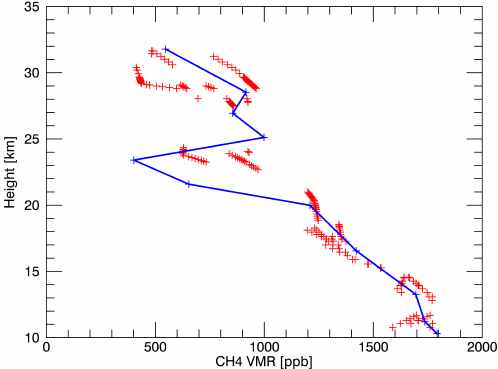
Figure 2. Comparison of the vertical profile obtained during flight B45 with the closest satellite measurements interpolated to the po- tential temperature of the trajectories at the point of the match. For this comparison only satellite data have been used which match the trajectory within 200km and a maximum time delay of 2 days. While the low values observed between 20 and 25km cannot be completely reproduced, these closest matches indicate a similar fea- ture as in the balloon data (see text for